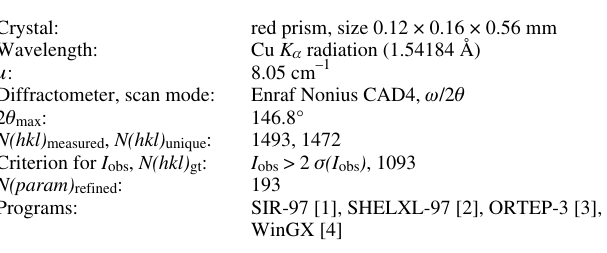
Table 1. Data collection and handling.